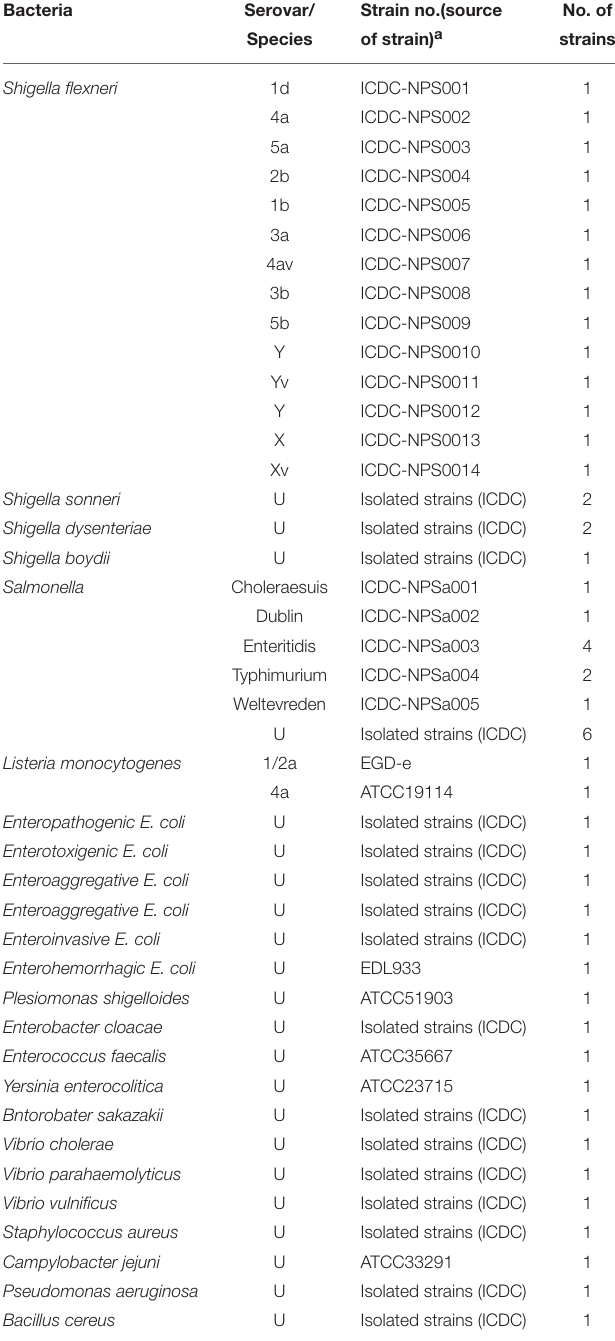
TABLE 2 | Bacterial strains used in this study. Bacteria Serovar/ Strain no.(source No. of